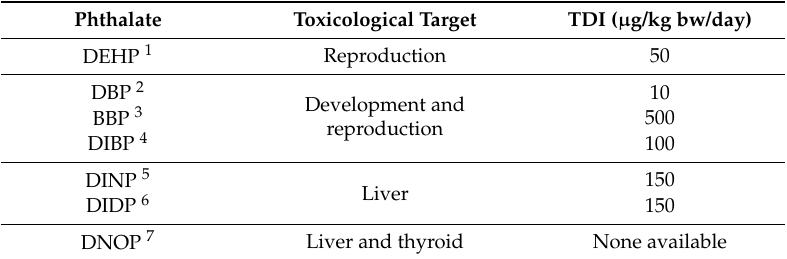
Table 2. European tolerable daily intake (TDI) values for individual phthalates. Phthalate Toxicological Target TDI ( µ g/kg bw/day) DEHP 1 Reproduction 50 10 DBP 2 Development and BBP 3 500 reproduction DIBP 4 100 150 DINP 5 Liver DIDP 6 150 DNOP 7 Liver and thyroid None